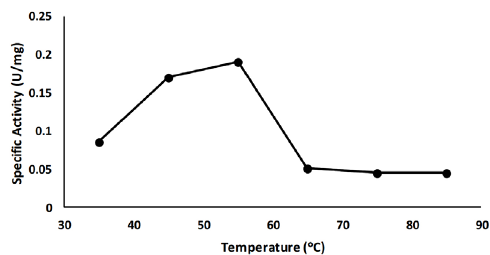
Fig. 3. Activity of 0-20 % fraction in wide different pH, maximum activity is showed on the pH 9